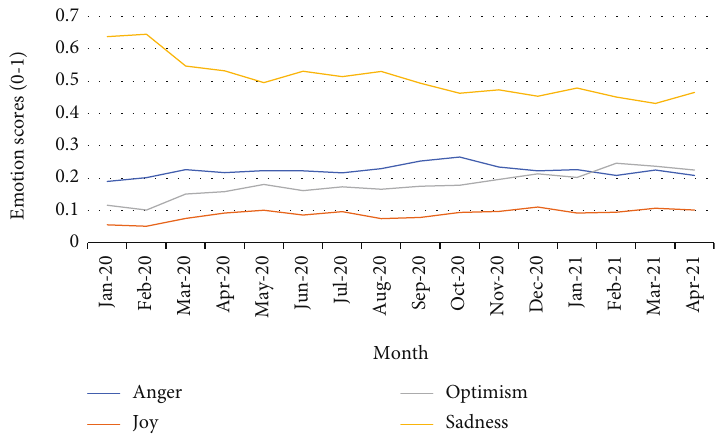
Figure 5: Chart showing monthly average emotion scores across The Guardian news tweets over